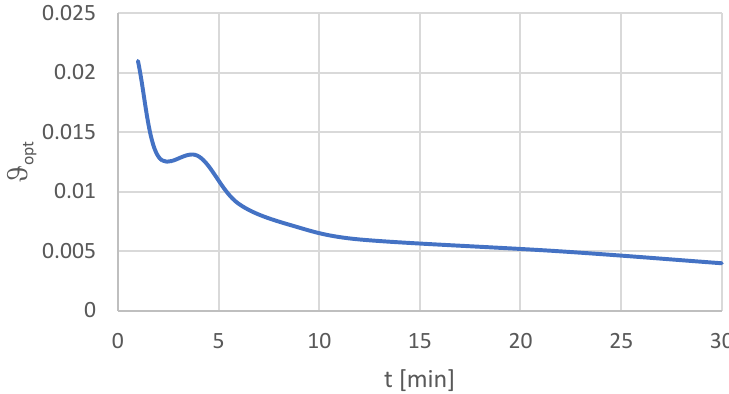
Figure 3. Relation ϑ opt (t). Figure 3. Relation  opt (t).